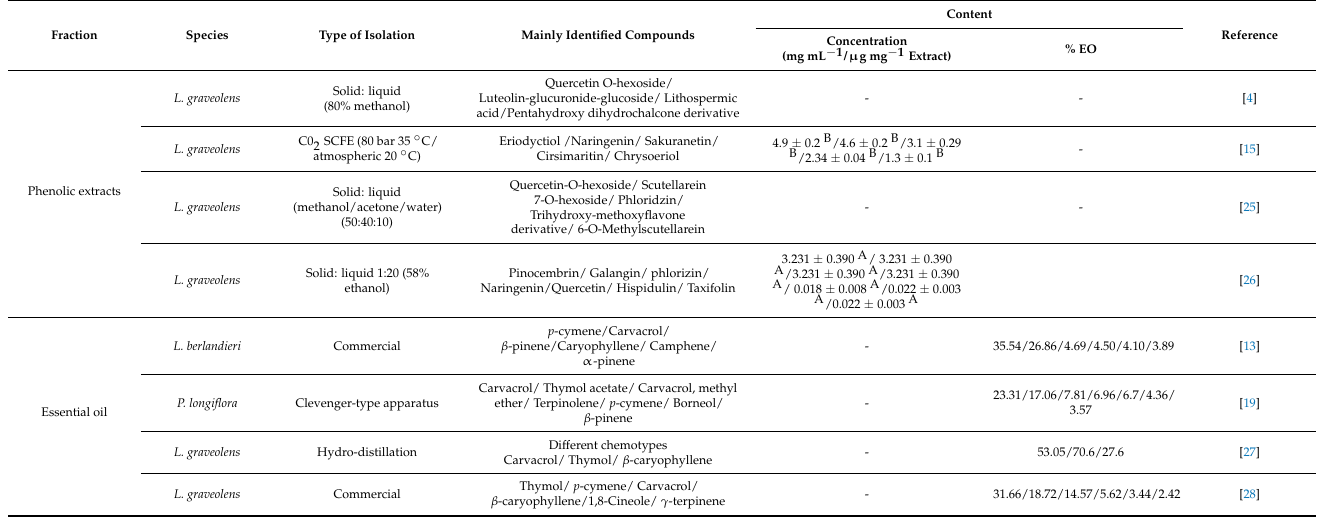
Table 1. Main compounds identified in L. graveolens and other Mexican oregano